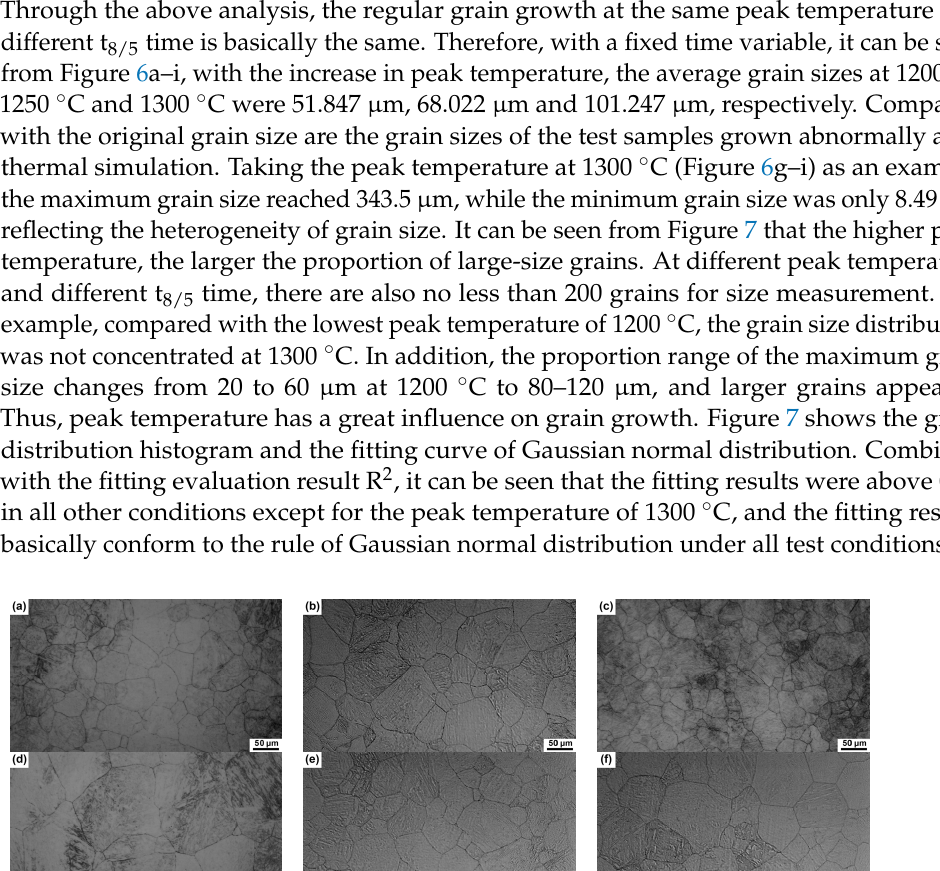
Figure 5. Grain distribution and normal fitting curve of the original sample and TP = 1200 °C: ( a ) original, ( b ) 1200 °C.